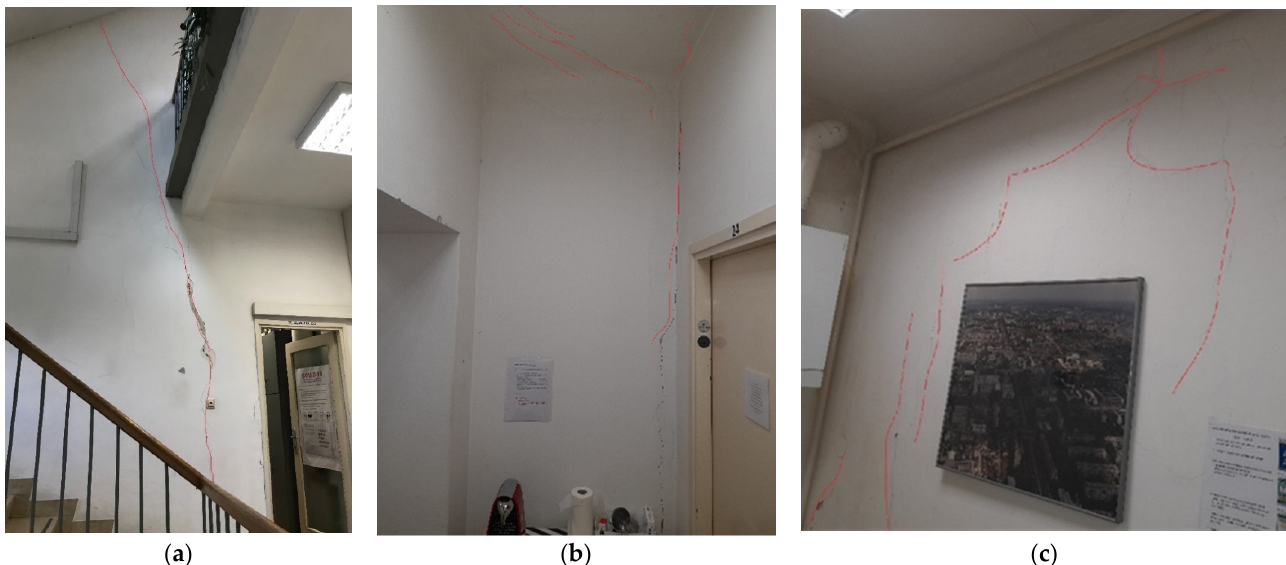
Figure 8. ( a ) Damage to the stair system; ( b ) Damage at the connections of load-bearing and partition walls; ( c ) Slight damage to the load-bearing walls.